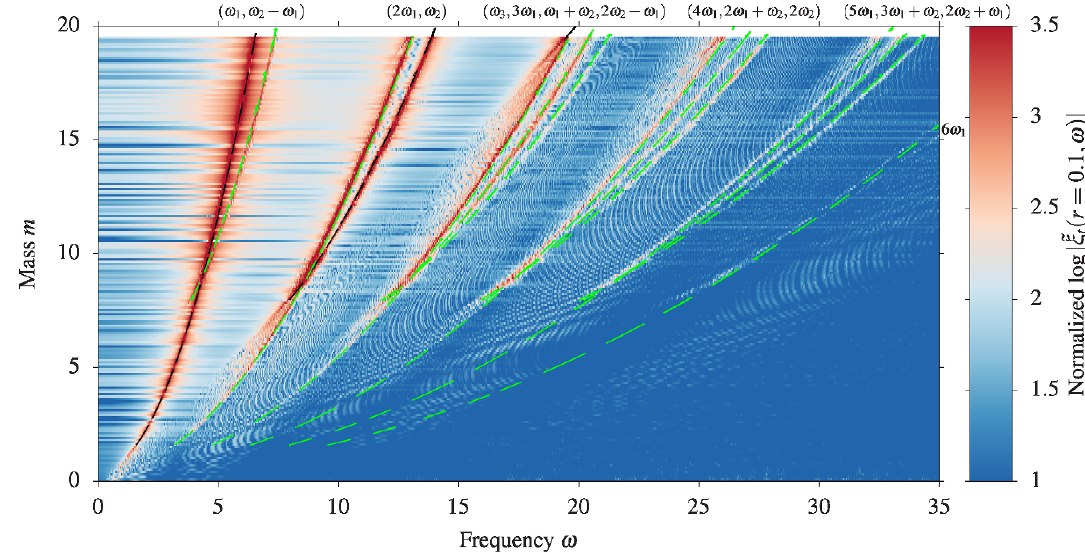
Figure 1 . Power spectra of the full dynamics for the usual Skyrme potential with the pion mass m [0 ; 20], with the (cid:12)rst three oscillating modes (black dashed) and higher harmonics (green 2 dashed) denoted.